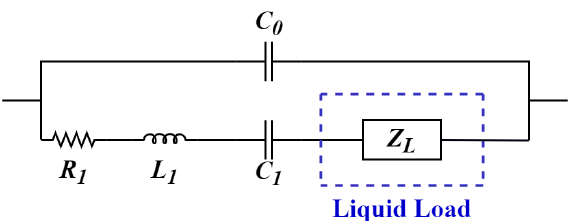
Figure 1. Butterworth-Van Dyke model of Quartz Crystal Resonators (QCR) with liquid